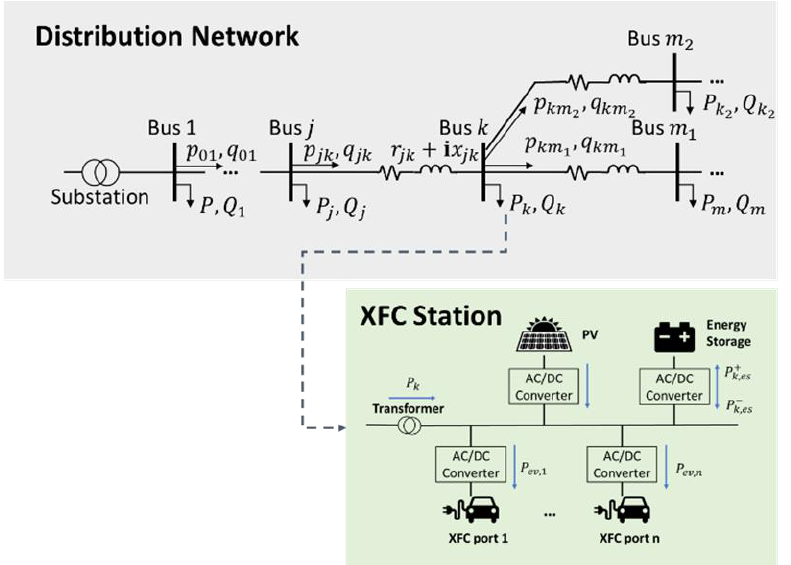
Figure 5. Schematic illustration of an XFC station with an ESS and PV panels connected to a distribu- tion network.